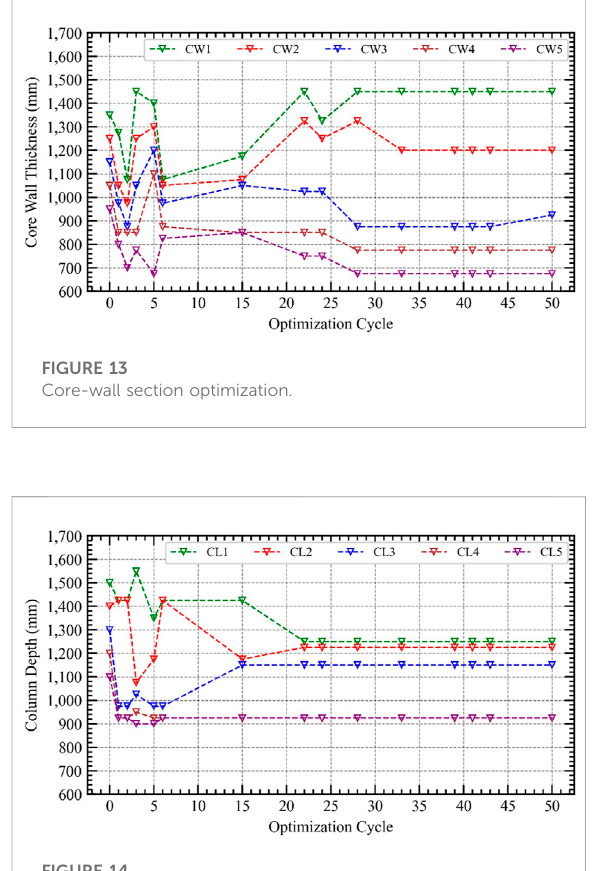
FIGURE 14 Column section optimization.